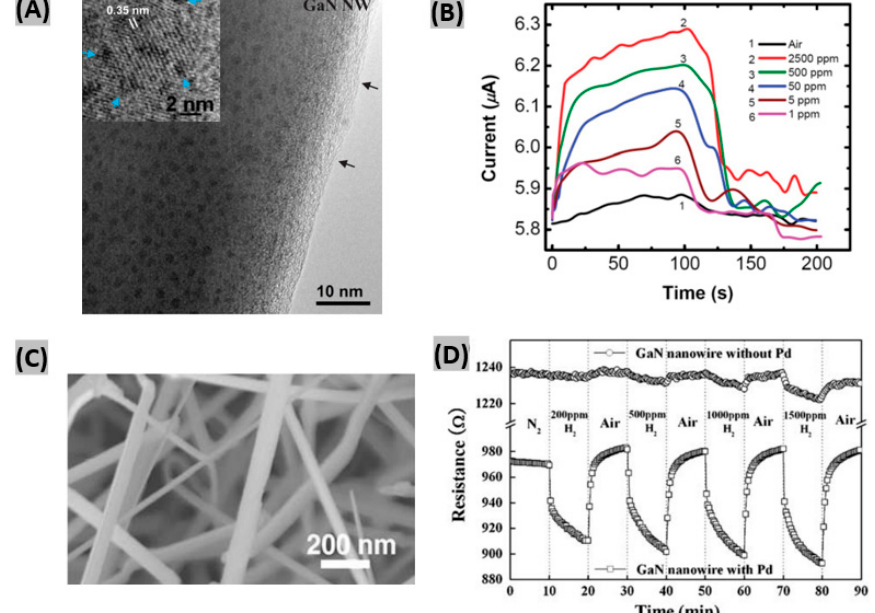
Figure 1. ( A ) HRTEM image of TiO 2 sputtered GaN NW after Pt deposition. Inset shows a